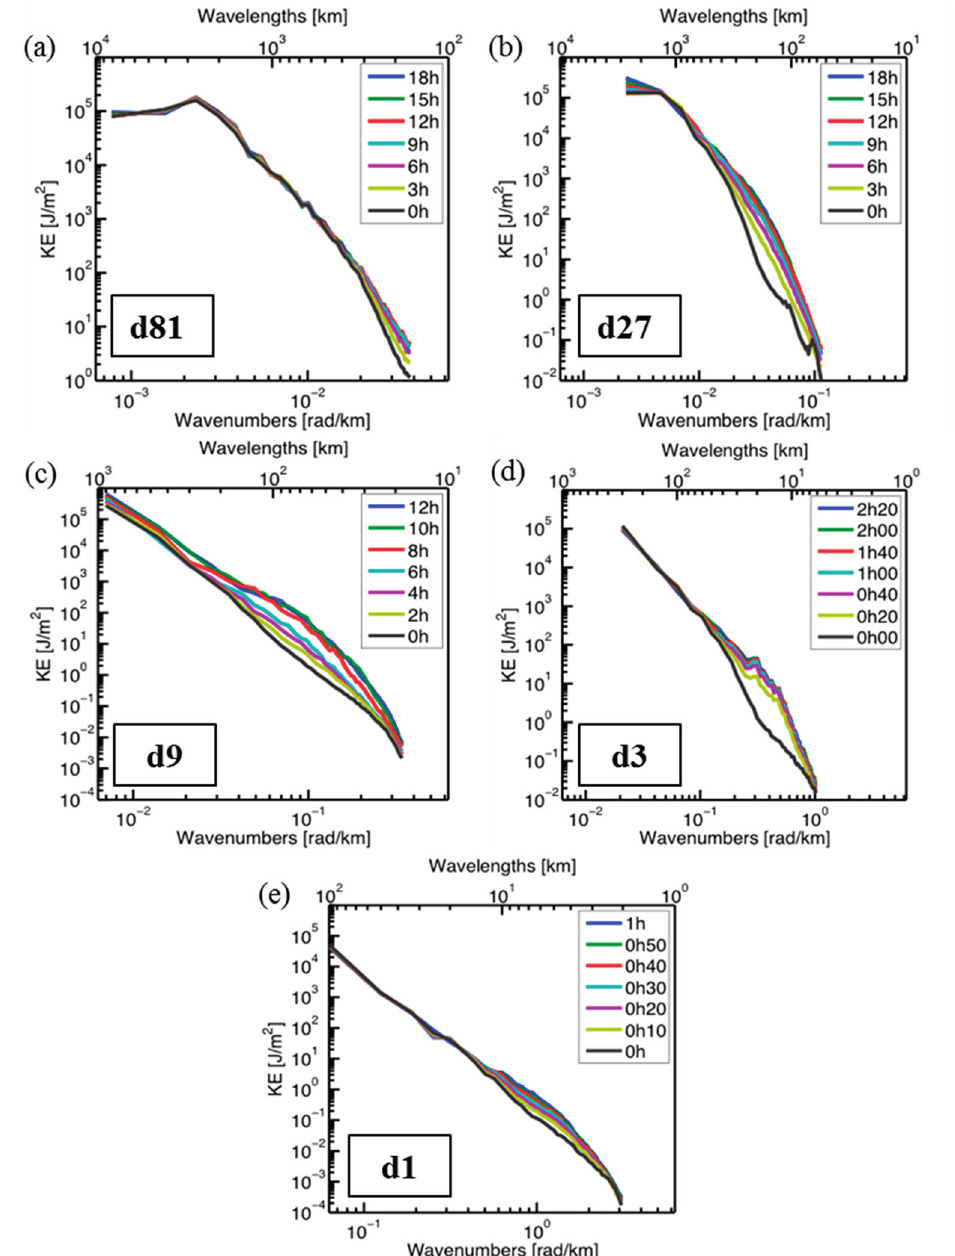
Figure 3. Kinetic energy (KE) spectra at various times after the launching of the ( a ) d81, ( b ) d27, ( c ) d9, ( d ) d3 and ( e ) d1 simulations. The different line colors correspond to different times in the simulation, as identified by the respective panels’ legends. The ordinates are the KE (J/m 2 ) vertically averaged from 700 to 200 hPa; the upper abscissas represent the wavelengths (km) and the lower abscissas the wavenumbers (rad/km). All axes are shown on logarithmic